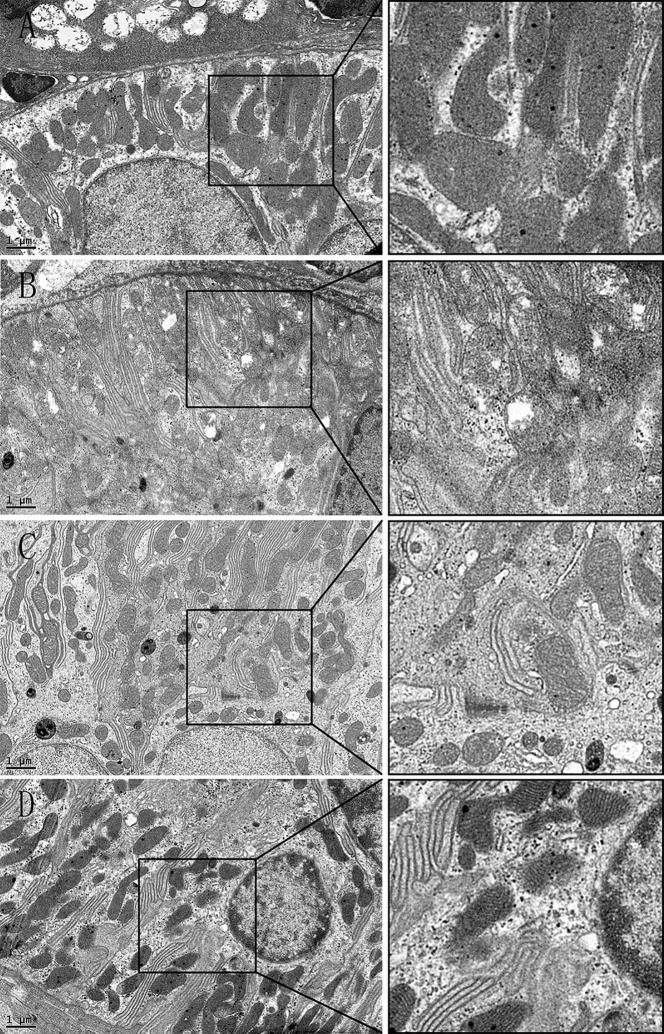
The striated duct of the submandibular gland.A, SHAM; B, OVX; C, OVX+ E; D, OVX+ iCR. Scale bars represent 1 μm. In the SHAM group, there was no obvious swelling or crest fracture in the mitochondria of the striated ducts. In contrast, many of the mitochondria were swollen, with double membrane structure damage, crest fracture in OVX group, but the condensed chromatin morphology was rarely observed. Both treatments improved this deleterious effect, resulting in mitochondria of normal appearance.